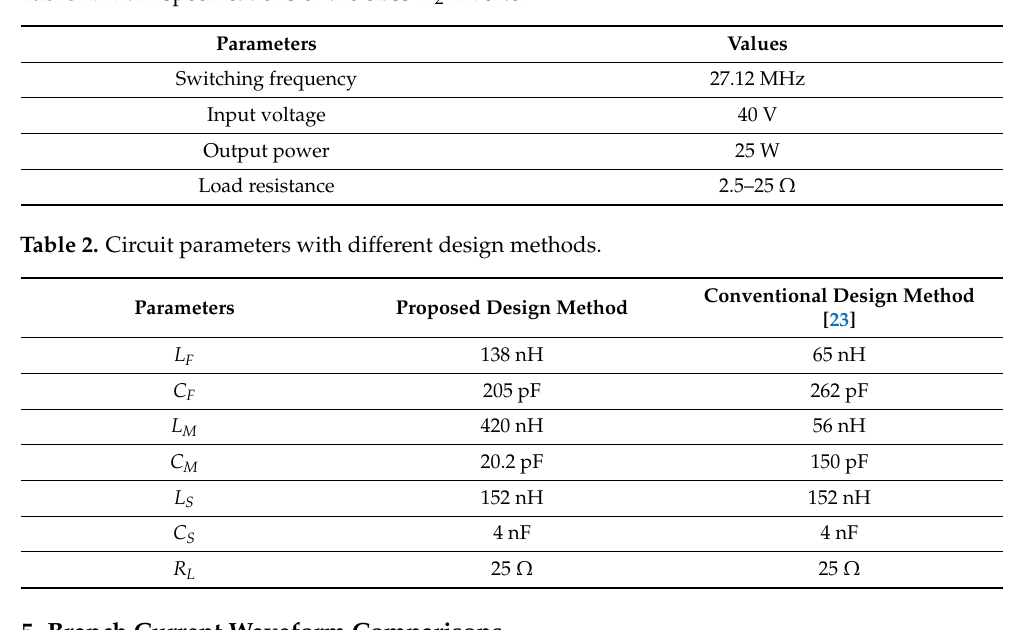
Table 1. Main specifications of the class Φ 2 inverter.